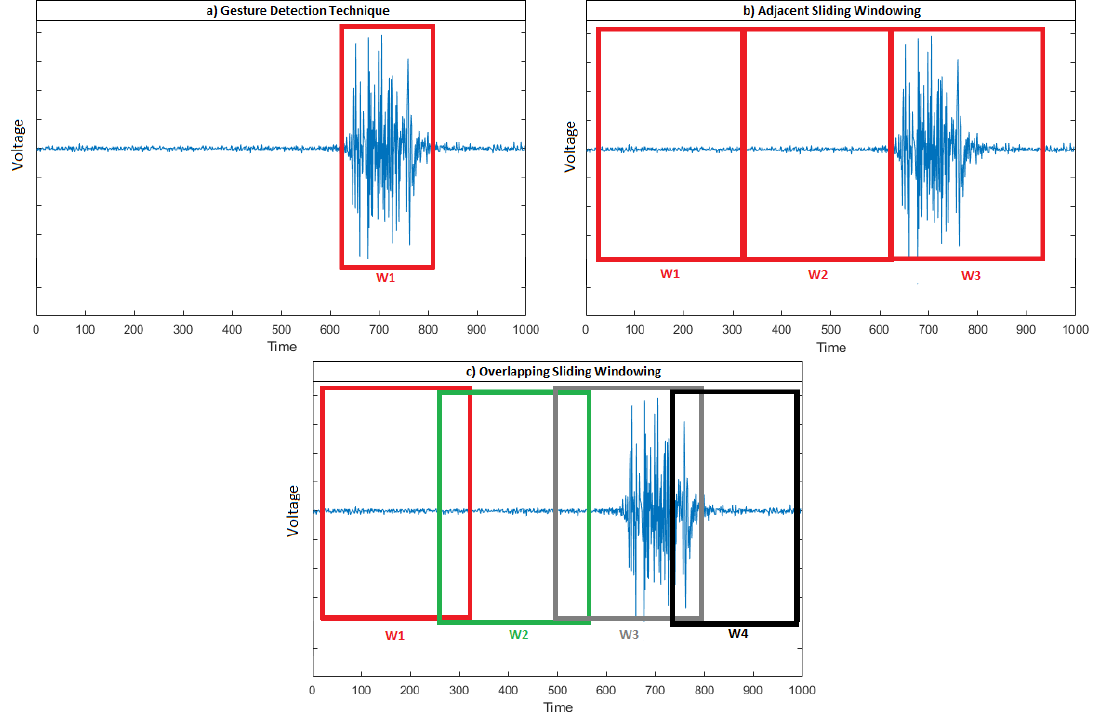
Figure 4. Segmentation of the EMG of a gesture using the three techniques: ( a ) gesture detection, ( b ) adjacent sliding windowing, and ( c ) overlapping sliding